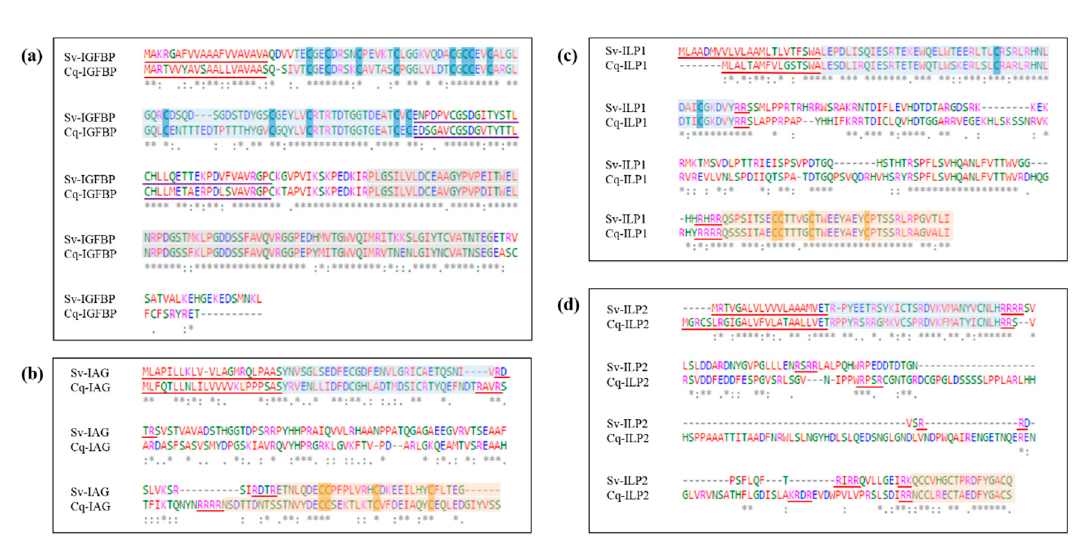
Figure 2. Sequence alignment of Sagmariasus verreauxi and Cherax quadricarinatus IGFBP and ILP homologues, with emphasis on the conservation of physicochemical properties. Residues are colored in accordance with properties: red—defines small, hydrophobic residues; blue—negatively charged/acidic; magenta—positively charged/basic; and green—polar and amine groups. An asterisk (*) indicates a conserved amino acid, a colon (:) those with conserved physicochemical properties, and a full stop (.) those with weakly similar properties. ( a ) Compares Cq-IGFBP and Sv-IGFBP, the signal peptide is underlined in red, the insulin-binding domain boxed in blue with the cysteine core highlighted, the kazal domain underlined in purple, and the C’ immunoglobulin domain boxed in grey. ( b ) Compares Cq-IAG and Sv-IAG; ( c ) Sv-ILP1 and the novel Cq-ILP1; and ( d ) the novel Sv-ILP2 and Cq-ILP2. In each case the signal peptide is underlined in red and the mature hormone is highlighted as the B-(blue) and A-(orange) chains with the cysteine core of each highlighted; C-peptide Arg-C proteinase cleavage sites are underlined in red.